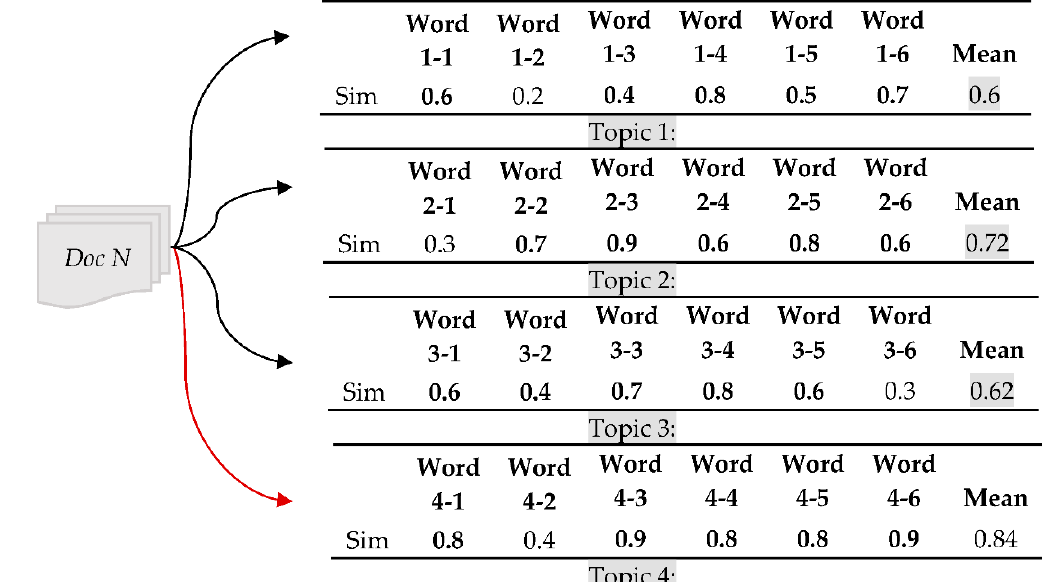
Figure 5. Method of document topic determination.